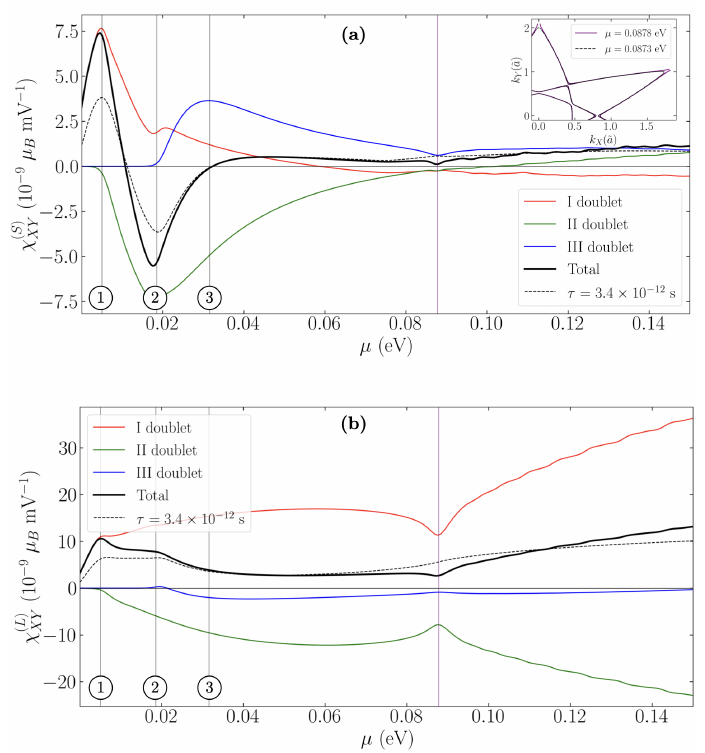
Figure A3. Spin ( a ) and orbital ( b ) Edelstein coefficient as a function of the chemical potential using a scattering time model with a point-like impurity. The different colours correspond to the contribution of a specific Kramers doublet, whereas the dashed line corresponds to the total Edelstein response for a constant τ . The inset in panel ( a ) corresponds to the detail of the Fermi energy contour for the purple chemical potential